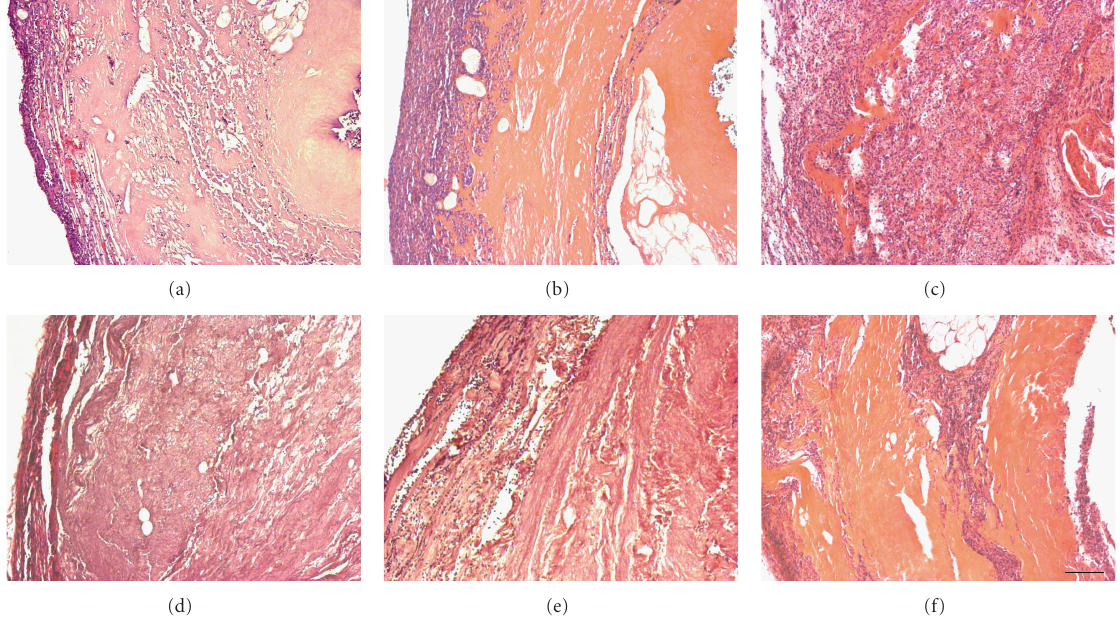
Figure 4: Transverse section of subcutaneous untreated (a–c) and GP cross-linked (d–f) implants after 1, 9, and 30 days in vivo . At day 1 postimplantation, untreated sca ff olds (a) displayed a cellular infiltration with granulocytes, fibroblasts, and macrophages, whereas in GP cross-linked sca ff olds (d) only a cellular layer was detectable at the periphery. At day 9 postimplantation, a considerable increase of infiltrating cells into untreated sca ff olds (b) was detected as a sign of encapsulation, whereas GP cross-linked (e) sca ff olds showed a cellular infiltration with granulocytes, fibroblasts, and macrophages without signs of encapsulation. At day 30 postimplantation, whole implants of the untreated sca ff old group (c) were infiltrated with granulocytes, fibroblasts, and macrophages, whereas GP cross-linked sca ff olds (f) showed only an immaterial cellular infiltration. In contrast to GP cross-linked sca ff olds, untreated sca ff olds were largely degraded. See Figure 5 for detailed cellular analysis. Magnification: × 100, bar = 100 μ m.